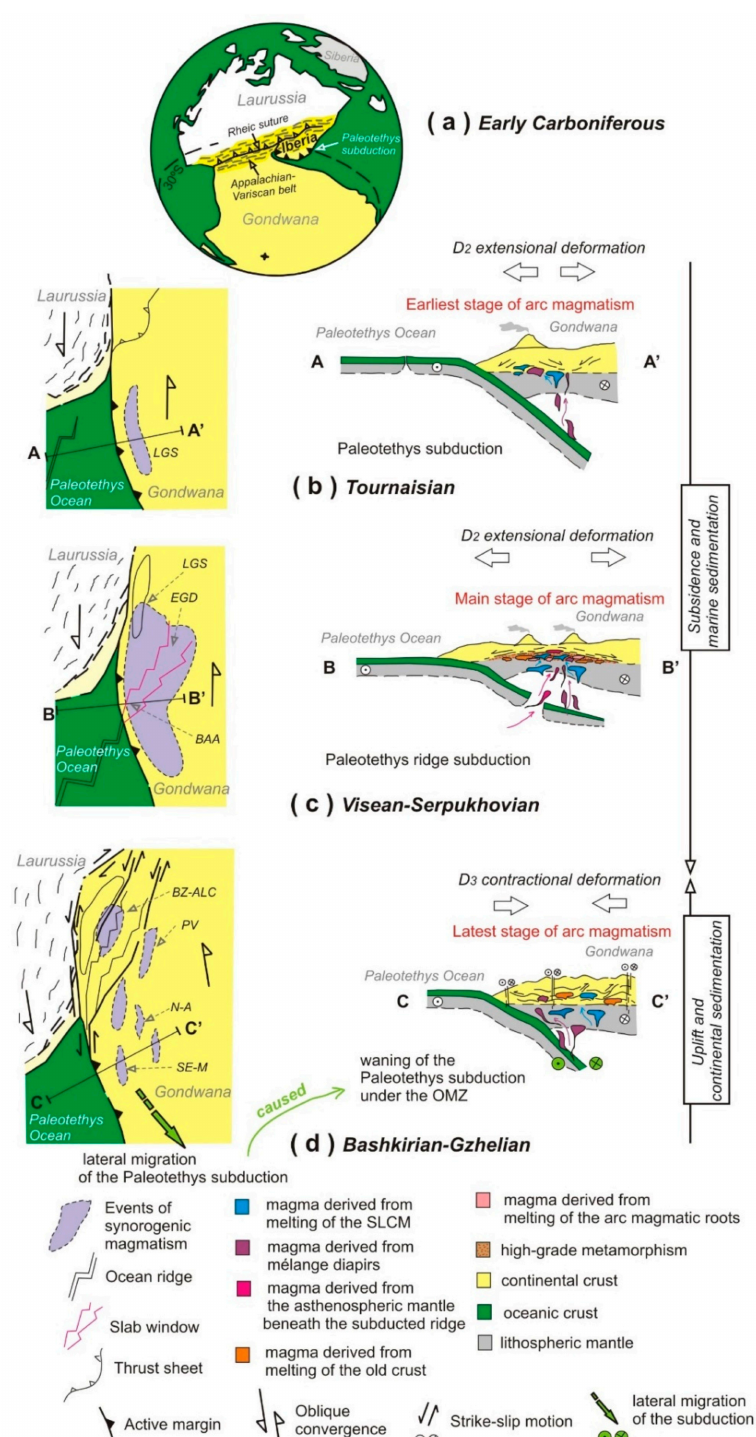
Figure 10. ( a ) Paleogeographic reconstruction for the Carboniferous showing the Appalachian- Variscan belt, the Rheic suture and the Paleotethys subduction; ( b – d ) sketches showing assumed tectonic evolution recorded in SW Iberia, with the sequence of Carboniferous stages of arc magmatism that took place during the Laurussia-Gondwana oblique collision and the Paleotethys subduction (modified from [16,18]. BAA: Beja-Acebuches Amphibolites; BZ-ALC: Baleiz ã o porphyries and Alc á çovas quartz diorites; Other Carboniferous OMZ plutonic rocks: EGD: É vora Gneiss Dome; LGS: Layered Gabbroic Sequence; N-A: Nisa-Albuquerque; PV: Pavia; PD: Los Pedroches; SE-M: Santa Eul á